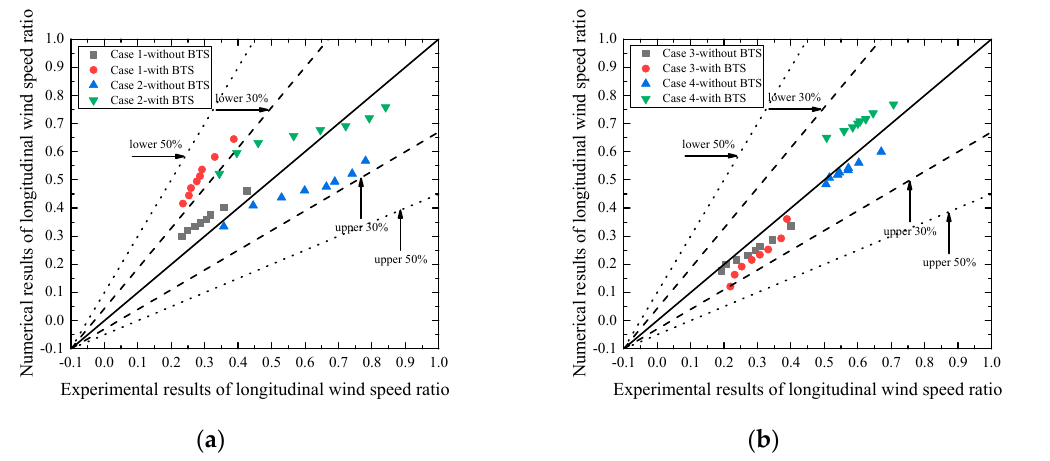
Figure 22. Numerical results vs. experimental results of longitudinal wind speed ratio at 3L/4 under different cases. ( a ) Case 1 and 2; ( b ) Case 3 and 4.